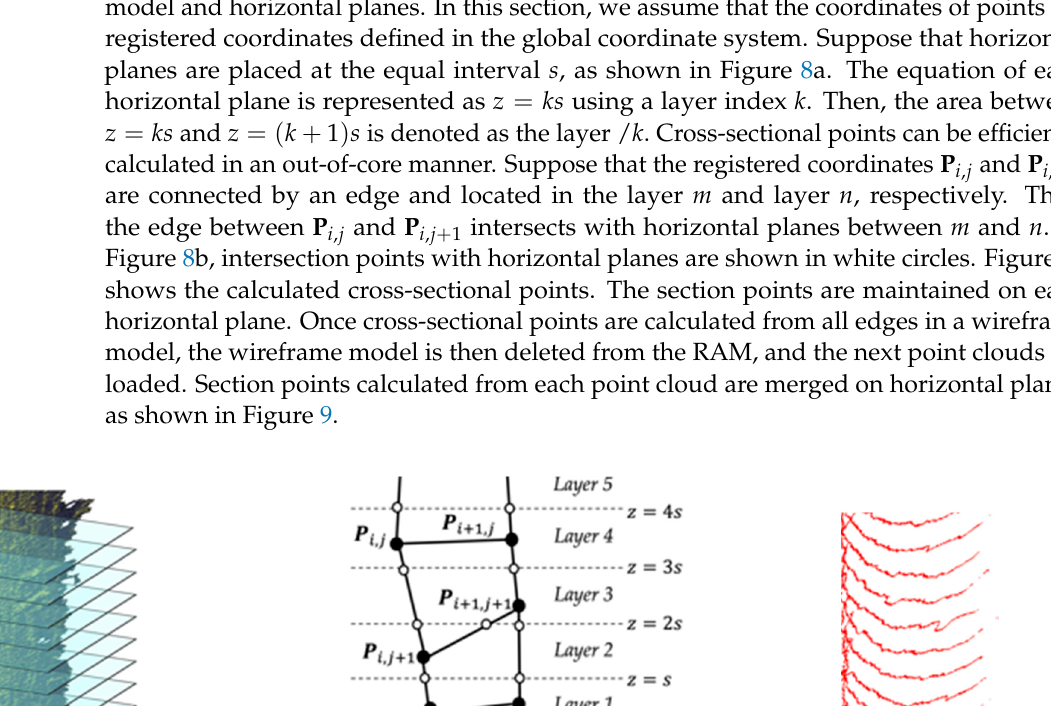
Figure 7. Segmentation into connected regions. ( a ) Connected regions; ( b ) removal of small regions.